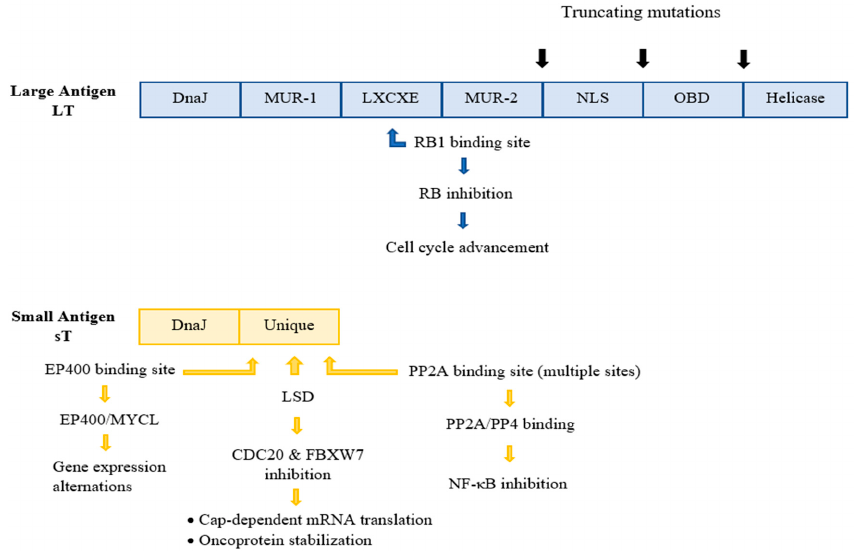
Figure 2. The structural domains of the early gene region antigens, LT and sT. The LT and ST are products of alternative splicing of the region. In MCC, a truncated version of LT is expressed, characterized by mutations that eliminate domains of the C-terminus of LT, naming the nuclear localization signal (NLS), origin binding domain (OBD), and helicase domains. The crucial for the oncogenesis LXCXE RB-binding motif is preserved. ST contains several unique motifs with multiple sites that bind and interact with a variety of host cellular proteins. The DnaJ domains, conserved in both antigens, are related to viral replication. NLS, Nuclear localization signal; MUR, MCPyV unique region; OBD, Origin binding domain, PP2A protein phosphatase 2A; EP400, E1A-binding protein p400; MYCL, L-myc-1 proto-oncogene protein; LSD, NF- κ B, Nuclear factor kappa B; LT- stabilizing domain; FBXW7m F-box/WD repeat-containing protein 7; CDC20, cell division cycle protein 20 homolog; PP4, Protein phosphatase